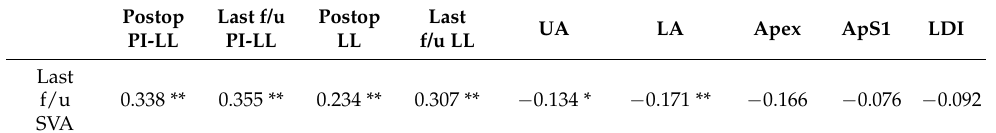
Table 3. Correlation between postoperative lumbar sagittal parameters.